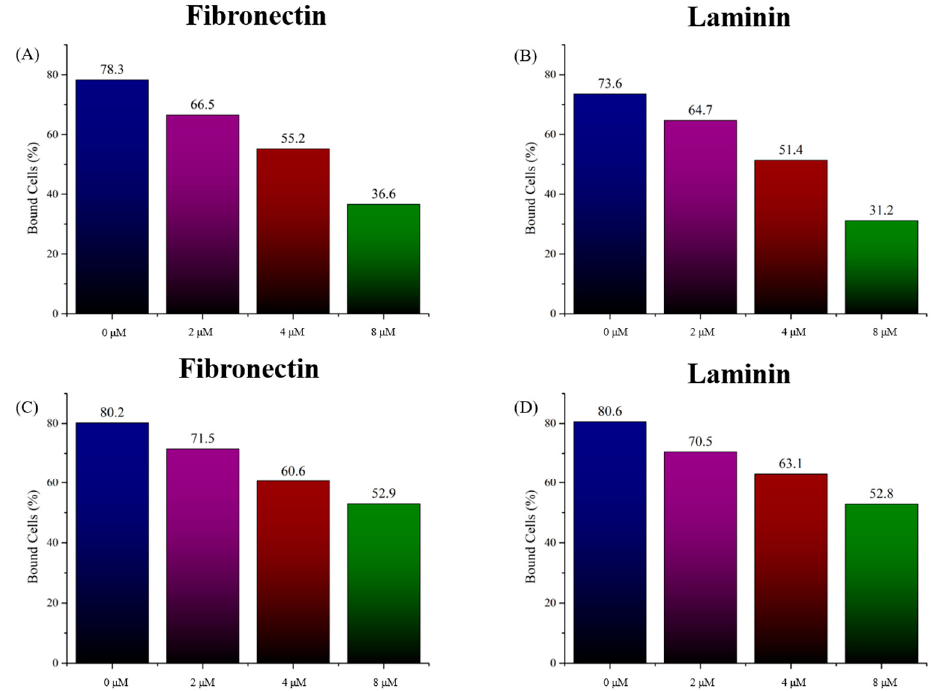
Figure 4. Influence of compound 4b and Celecoxib on SW620 cell adhesion to fibronectin and laminin. ( A ) Influence of compound 4b on SW620 cell adhesion to fibronectin; ( B ) influence of compound 4d on SW620 cell adhesion to laminin; ( C ) influence of Celecoxib on SW620 cell adhesion to fibronectin; ( D ) influence of Celecoxib on SW620 cell adhesion to laminin.